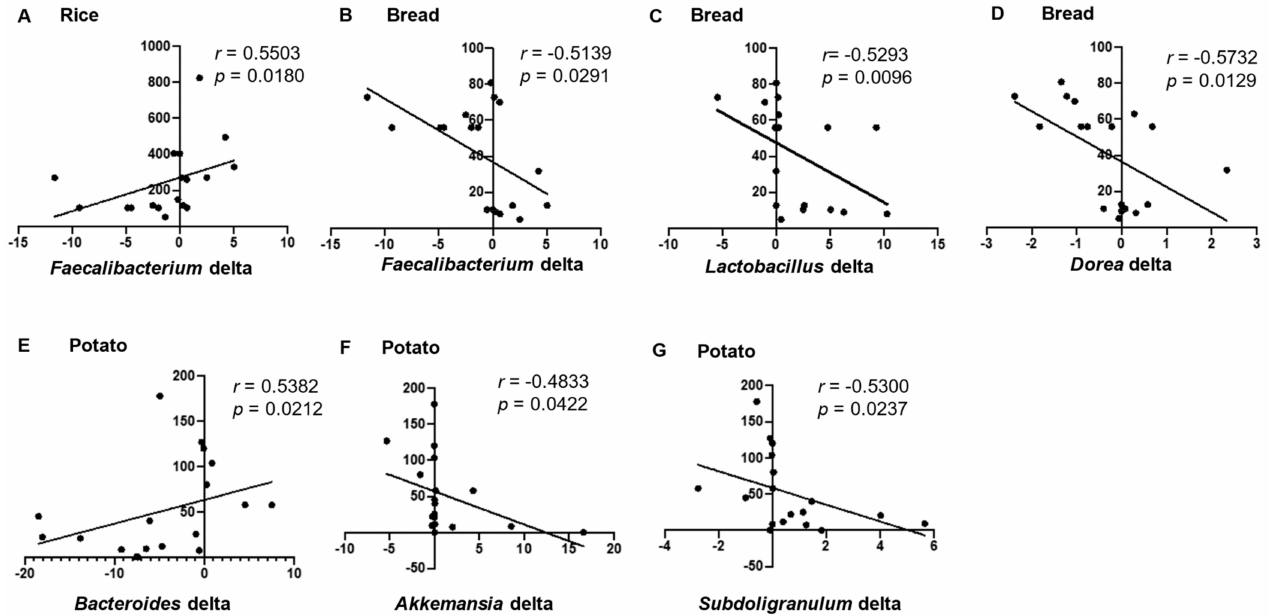
Figure 4. Correlation between the intake of various staple foods and changes in microbial data. Spearman’s correlation between the relative abundance delta of microbial data and the intake of various staple foods with statistical significance. X delta = X after intervention − X before intervention. ( A ), represents correlation between rice intake and Faecallbacterium delta; ( B ), represents correlation between bread intake and Faecallbacterium delta; ( C ), represents correlation between bread intake and Lactobacillus delta; ( D ), represents correlation between bread intake and Dorea delta; ( E ), represents correlation between potato intake and Bacteroides delta; ( F ), represents correlation between potato intake and Akkemanisa delta; and ( G ), represents correlation between potato intake and Subdoligranuium delta. Table 2. Association between the intake of various staple foods and changes in microbial